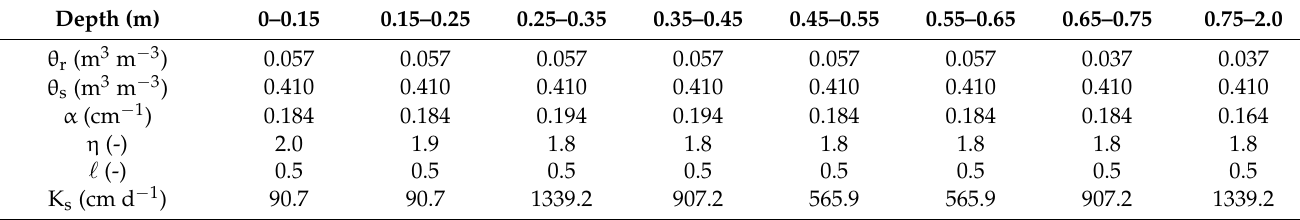
Table 2. Calibrated soil hydraulic